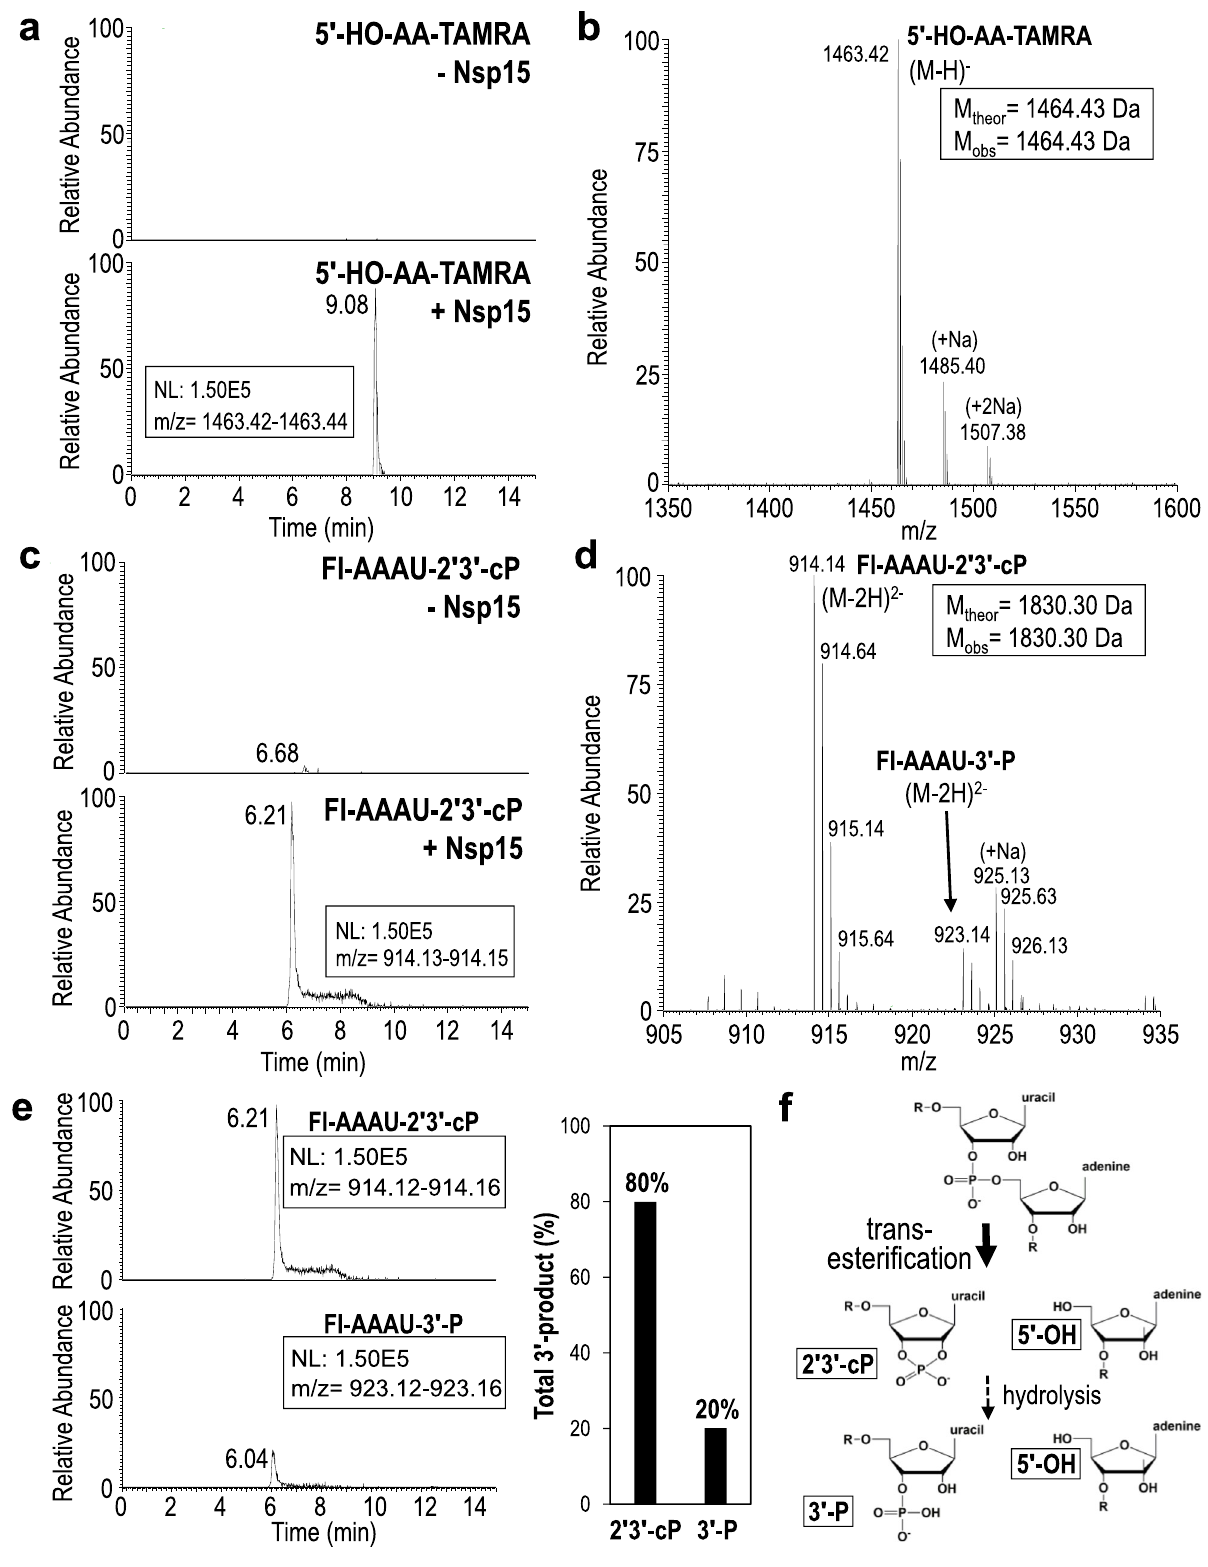
ef fi ciently as RNase A. We superimposed the active sites of Nsp15 and RNase A using a crystal structure of RNase A solved in the presence of 3 ′ -UMP 25 . H250 and K290 of Nsp15 superimpose well with the equivalent H12 and K41 residues from RNase A (Fig. 4a, b). In contrast, H235 from Nsp15 and H119 from RNase